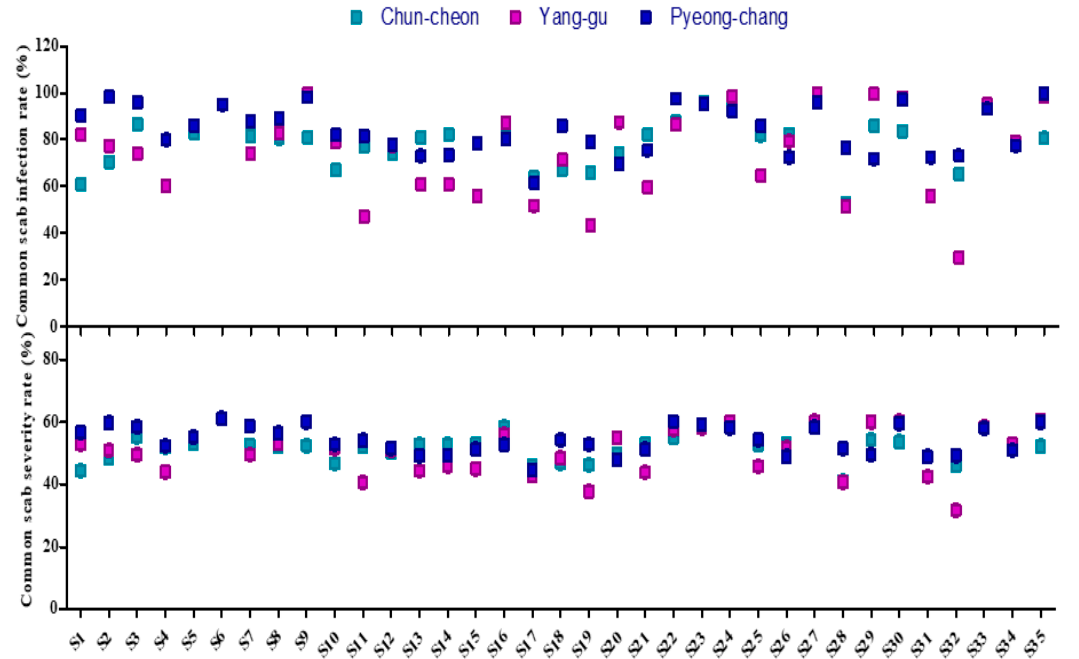
Figure 3. Tuber common scab infection rate (%) and tuber common scab severity rate (%) of 35 potato lines grown in three agro-ecological regions: Chuncheon (low altitude), Yang-gu (middle altitude), and Pyeong-chang (alpine) in South Korea. The bars represent standard error mean (SEM). We also observed a different range of common scab severity in three different locations.